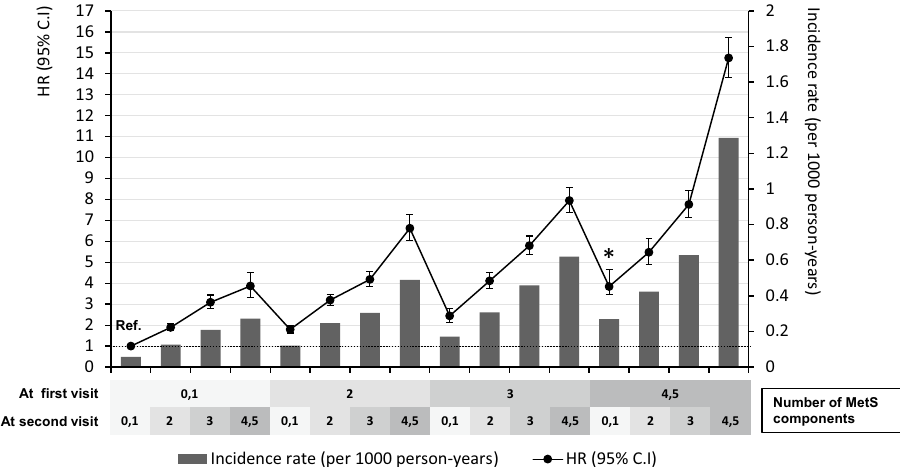
Figure 2. Adjusted hazard ratios, 95% confidence intervals, and incidence rates of end-stage renal disease according to changes in the number of metabolic syndrome components as reference with the subjects with 0–1 MetS components at both exams over two years. The model was adjusted for metabolic syndrome components at first visit, age, sex, smoking, alcohol consumption, exercise, and estimated glomerular filtration rate. *The subjects whose the number of MetS components decreased from 4–5 even to 0–1, the HR for the risk of ESRD remained 3.84 (95% CI, 3.17–4.67) compared with subjects who persistently had 0–1 MetS components over two years.